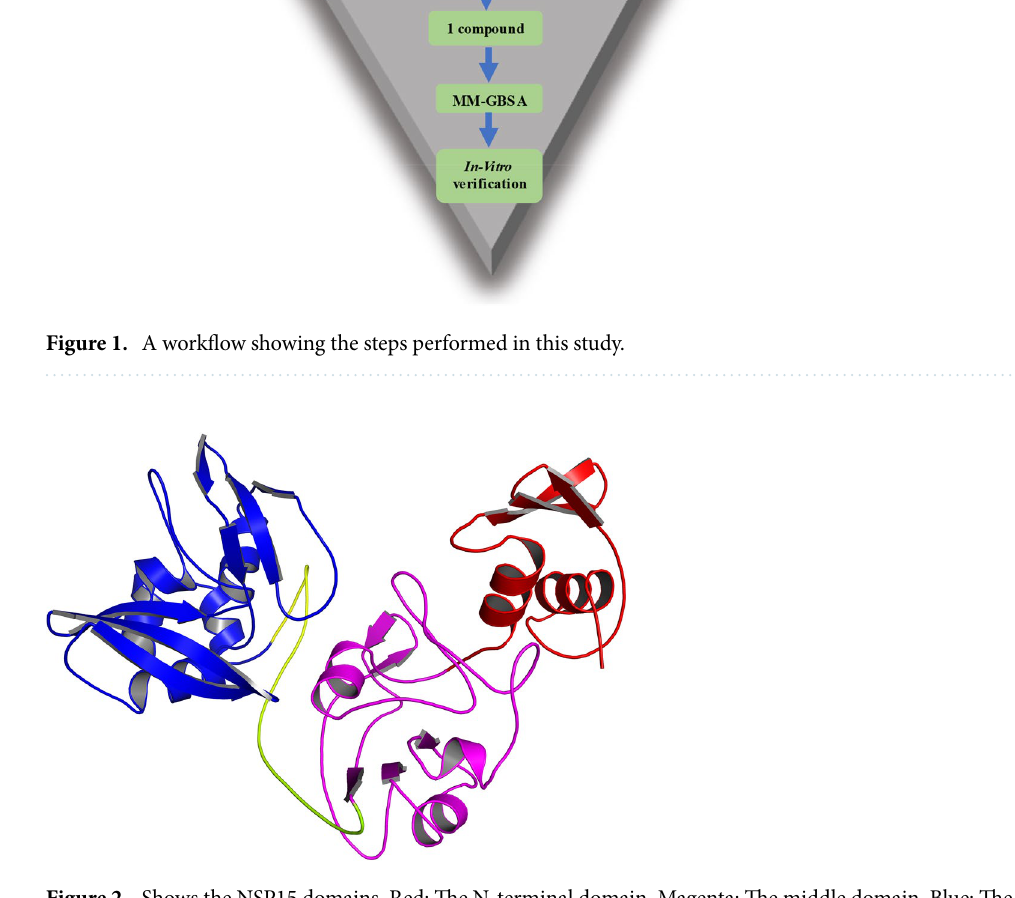
Figure 2. Shows the NSP15 domains. Red: The N-terminal domain. Magenta: The middle domain. Blue: The C-terminal domain which contains the active site of the